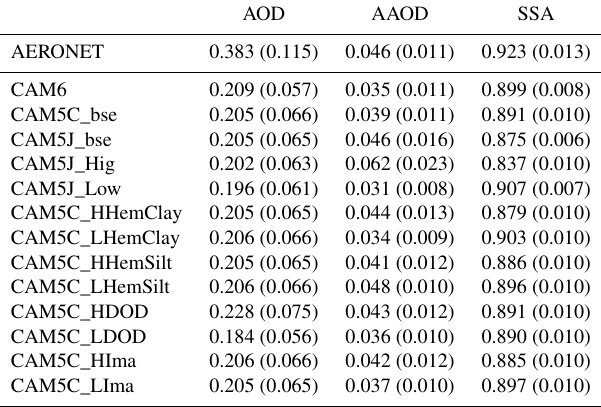
Table 6. The climatologically mean AOD, AAOD, and SSA at 0.55µm for AERONET (first portion) and at Band 10 centered at 0.53µm for CAM5/6 (second portion). Values from CAM5/6 with J2014 (J) and/or C1999 (C) were obtained by averaging modeled AOD, AAOD, and SSA over the grid box nearest to the AERONET sites (e.g., Holben et al., 1998), where DOD > 0.5 · AOD. Val- ues in parentheses show the standard deviation of AOD, AAOD, and SSA. Other notations: C(J)_bse: the baseline simulation with C1999 (J2014); J_Hig(Low): high (low) bound of iron oxides in J2014, respectively; C_H(L)HemClay(Silt): high(low)-bound (see text for explanations) hematite in the clay(silt)-sized category; C_H(L)DOD: high(low)-bound DOD; C_H(L)Ima: high(low)- bound imaginary complex refractive index of minerals.